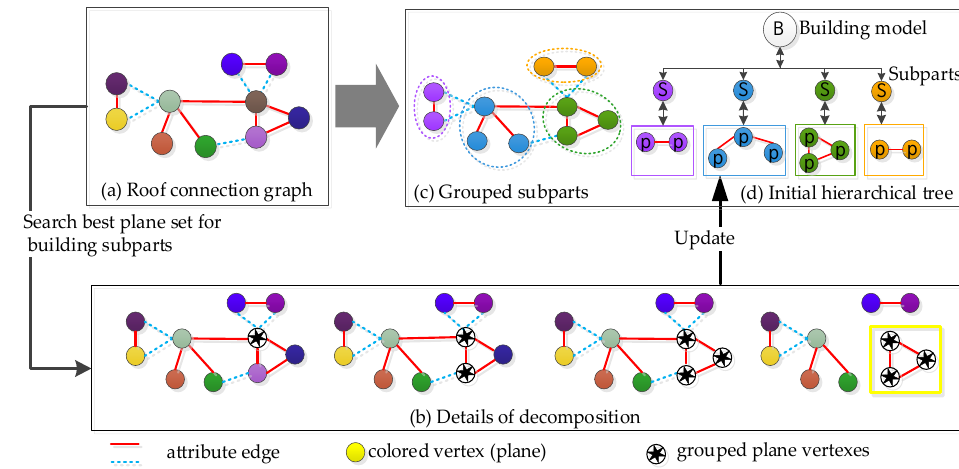
Figure 5. The detailed iteration of progressive decomposition.